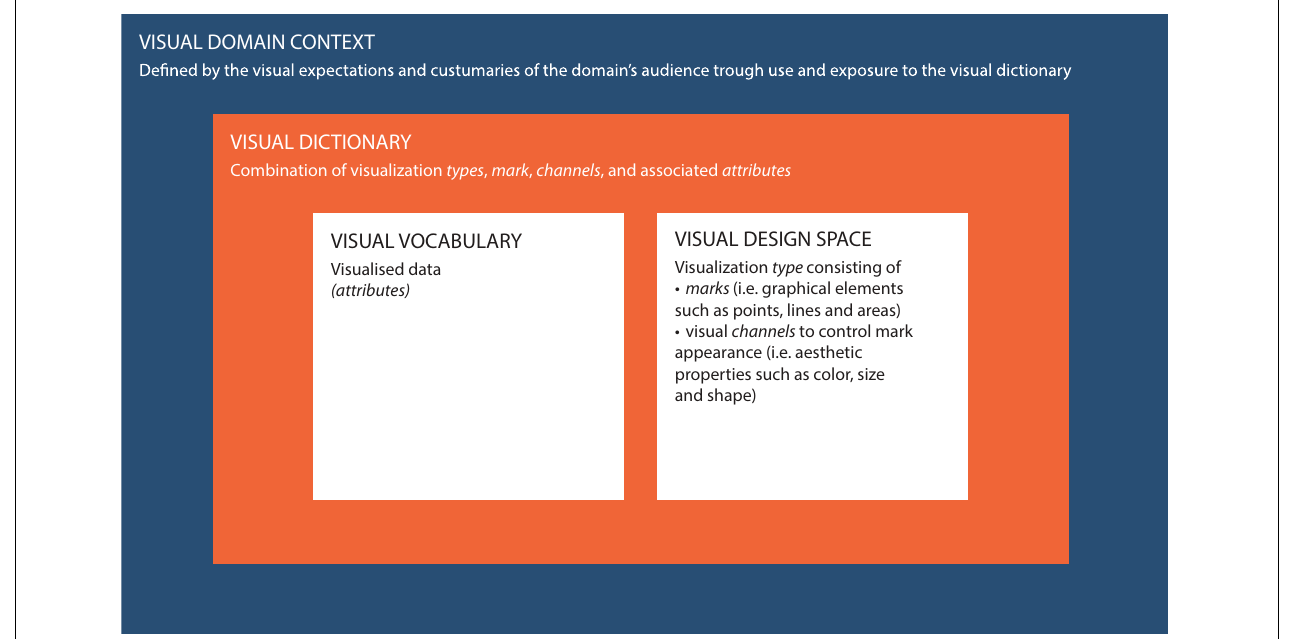
FIGURE 1 | Conceptual framework used in this study to clarify the definitions and interrelations between the visual domain context, the visual dictionary and the visual domain vocabulary and visual design space. To clarify the conceptual definitions a linguistic analogy can be used: a dictionary describes language in terms of both vocabulary (i.e., the set of words familiar in a language) and grammar/punctuation (i.e., the set of structural rules and supporting marks that control the composition and navigability of sentences, phrases, and words). Similarly, the visual dictionary describes visualizations in terms of both visual vocabulary (i.e., the domain content in terms of visualized data attributes) and visual design space (i.e., graphical elements and supporting aesthetic properties). The language or visual domain context is an overarching concept that represents language/visualization in practice, i.e., expectations and customs of the target audience, and how this affects their perception and interpretation of data visualizations. The visual domain context is, just as language, subject to changes over time and subject to interpretation differences based on varying